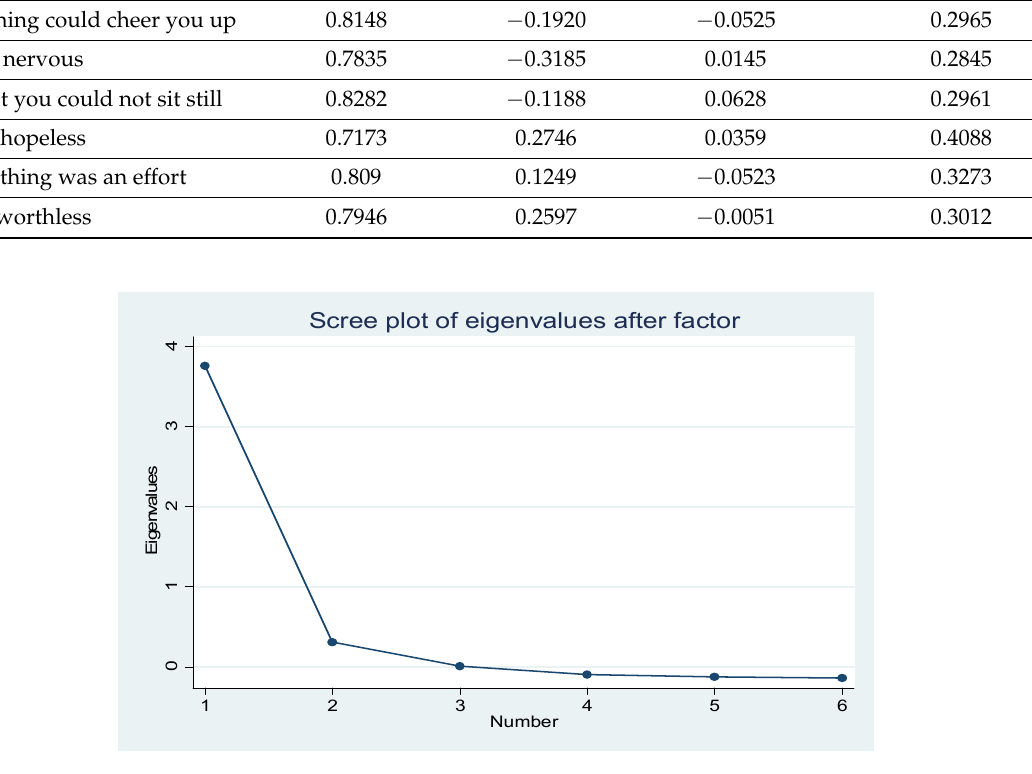
Figure 2. Scree plot of eigenvalues after factor.